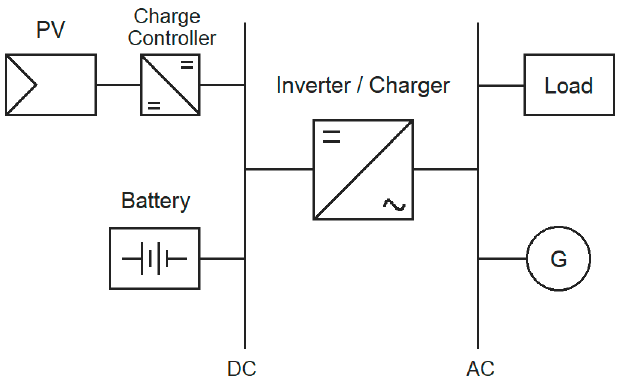
Figure 2. Off-grid system architecture of direct current (DC)-coupled PV–battery–generator sys-